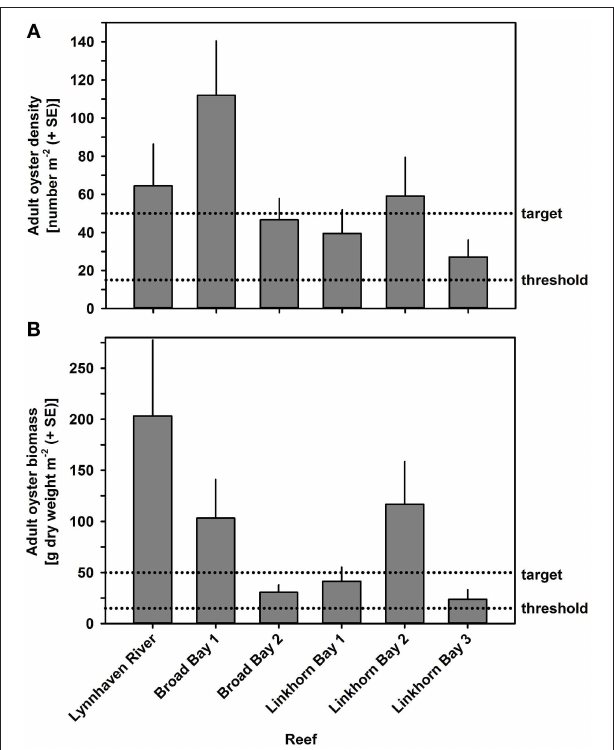
FIGURE 7 | Adult oyster density (A) and biomass (B) on constructed oyster reefs in the Lynnhaven River, Broad Bay, and Linkhorn Bay. Dotted lines represent the thresholds (15 oysters m − 2 or 15 g dry weight m − 2 of oysters) and targets (50 oysters m − 2 and 50 g dry weight m − 2 of oysters) for successful performance of constructed oyster reefs, as established by the Chesapeake Bay Program’s Sustainable Fisheries Goal Implementation Team (http://www.chesapeakebay.net/channel_files/17932/oyster_restoration_succe ss_metrics_final.pdf). Note that the thresholds and targets refer to oysters of all ages (juveniles + adults). Bars represent 1 standard error of the mean.